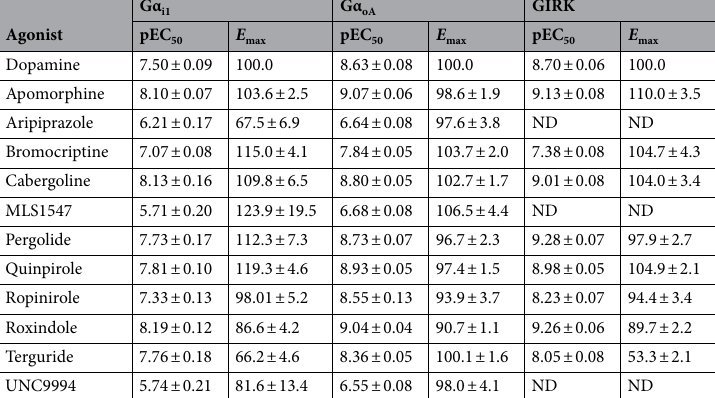
lent to that of DA in the more efficiently coupled Gα oA activation assay (Fig. 5B and Table 3). UNC9994 displayed the same maximal effect as DA in the Gα oA assay (Fig. 5A and Table 3). Finally, we measured activation of G